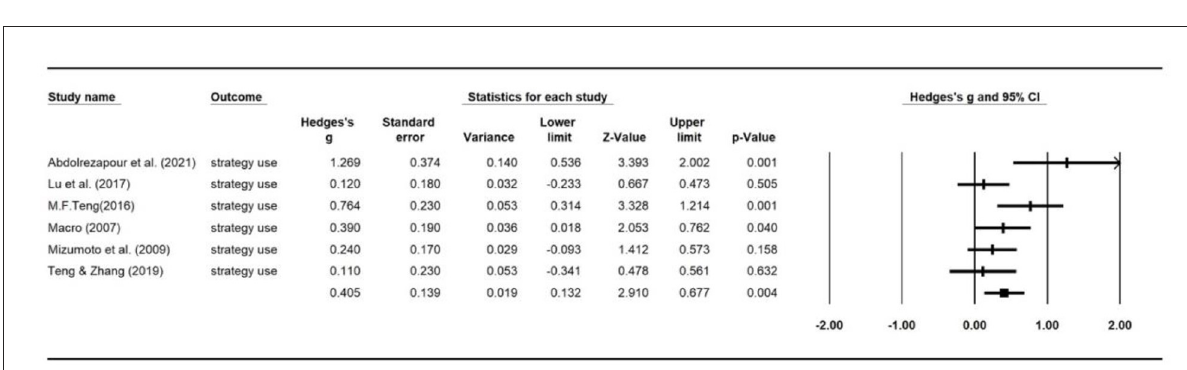
FIGURE7 Forest plot of overall effect size estimates for strategy use.